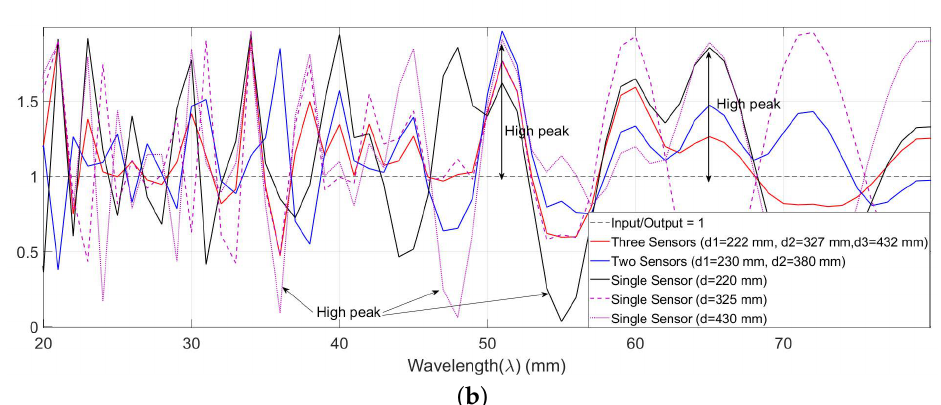
Figure 4. Comparison of magnitude of transfer function according to the number of sensors used; ( a ) Overall magnitude of the transfer function; ( b ) Magnitude of transfer function at specific wave- length range from 20 mm to 80